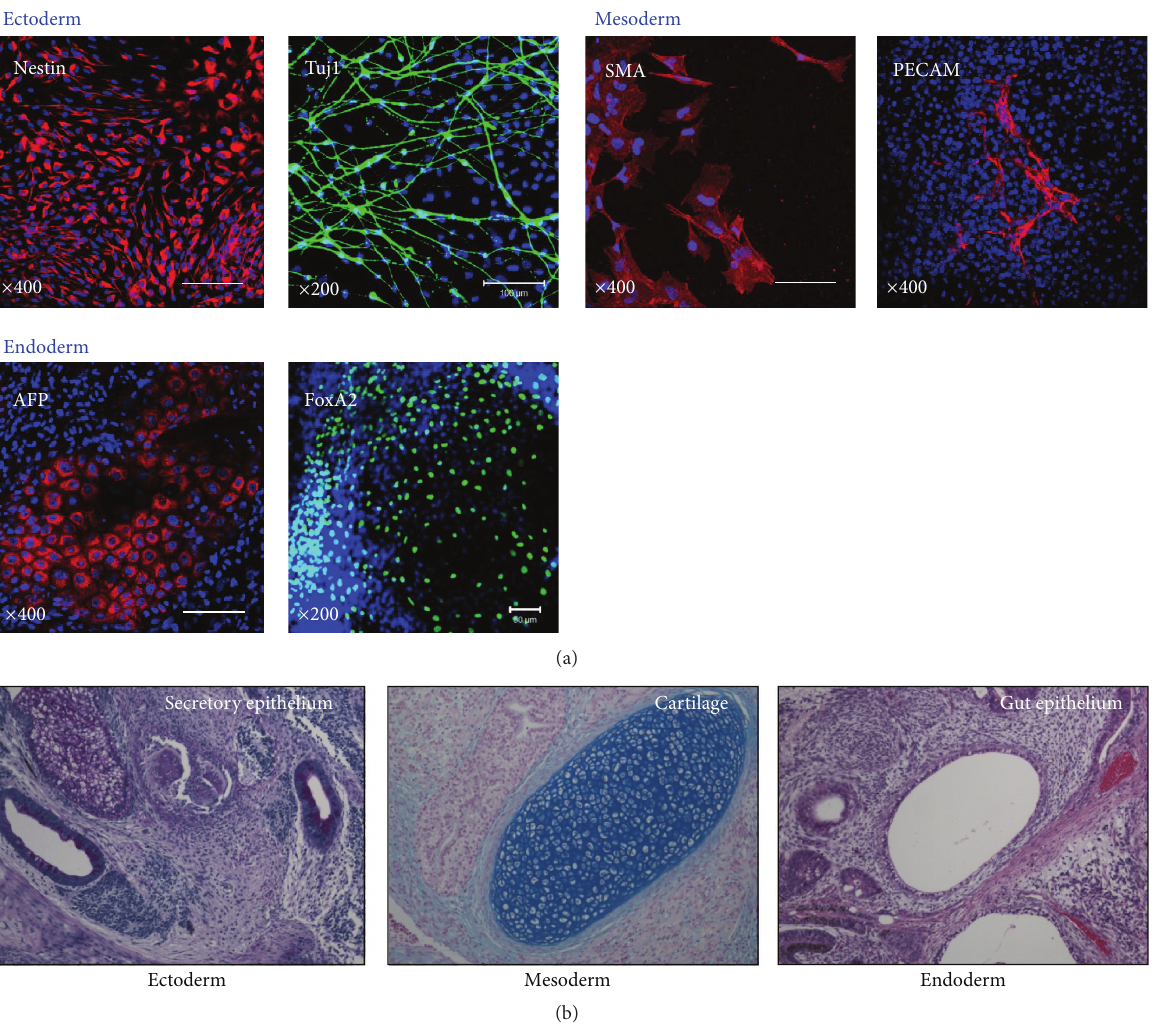
Figure 6: Analyses of pluripotency in vitro and in vivo. The mRNA-iPSCs were subjected to spontaneous differentiation via EB culturing, and the expression levels of representative markers of the ectoderm (Nestin and Class III 𝛽 -tubulin (Tuj1)), mesoderm (SMA and PECAM), and endoderm (AFP and FoxA2) lineages were examined. Scale bar: 100 𝜇 m. (b) Teratomas including structures and derivatives of the three germ layers were found at 3-4 months after intramuscular administration of the mRNA-iPSCs to NOD/SCID